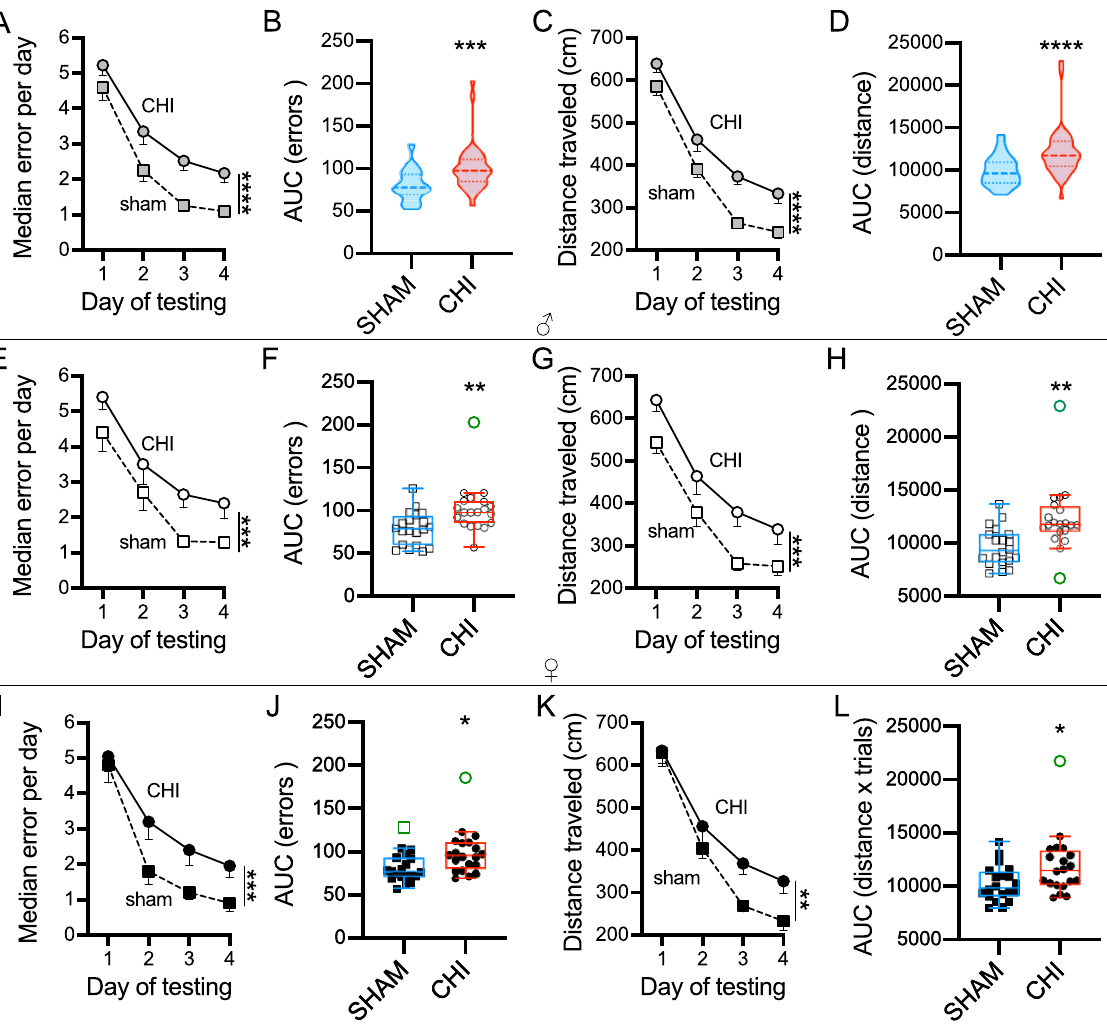
PLOS ONE | https://doi.org/10.1371/journal.pone.0232862 August 18,